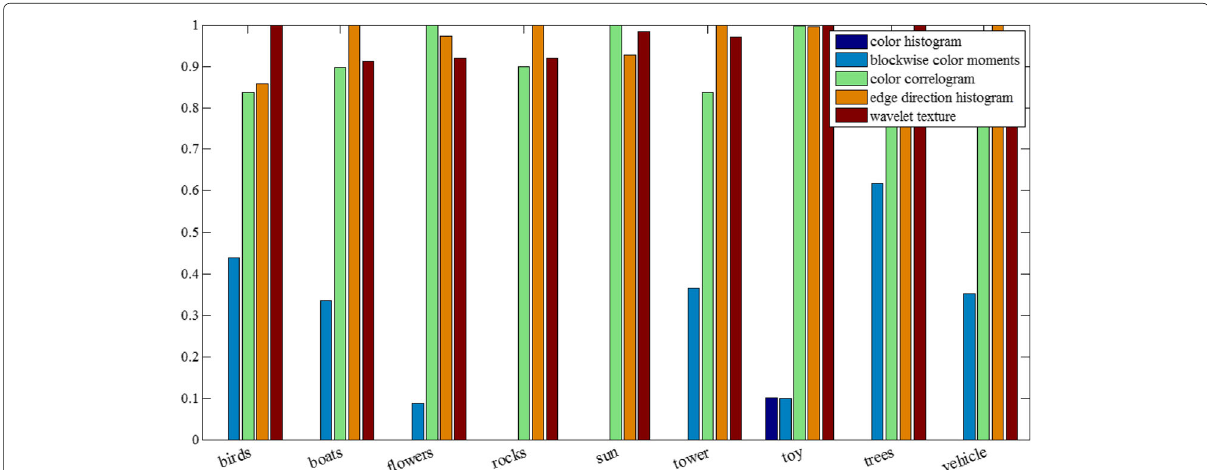
Fig. 7 Relative contribution ratios of features for each class of